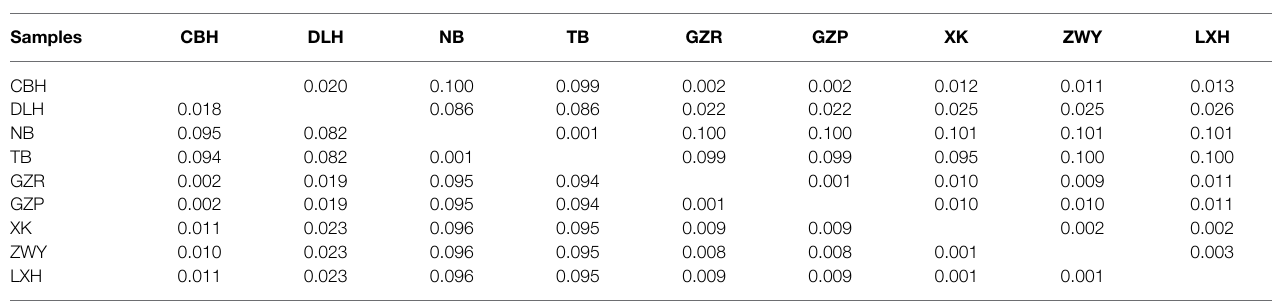
Upper, whole genome genetic distance and Lower, protein-coding genes genetic